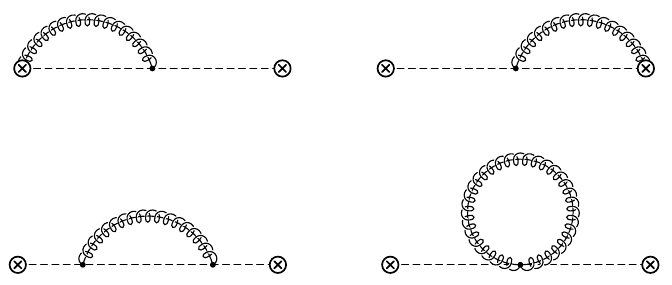
Figure 3 . Diagrams contributing to the one-loop jet function. The jet function is given by the sum over all